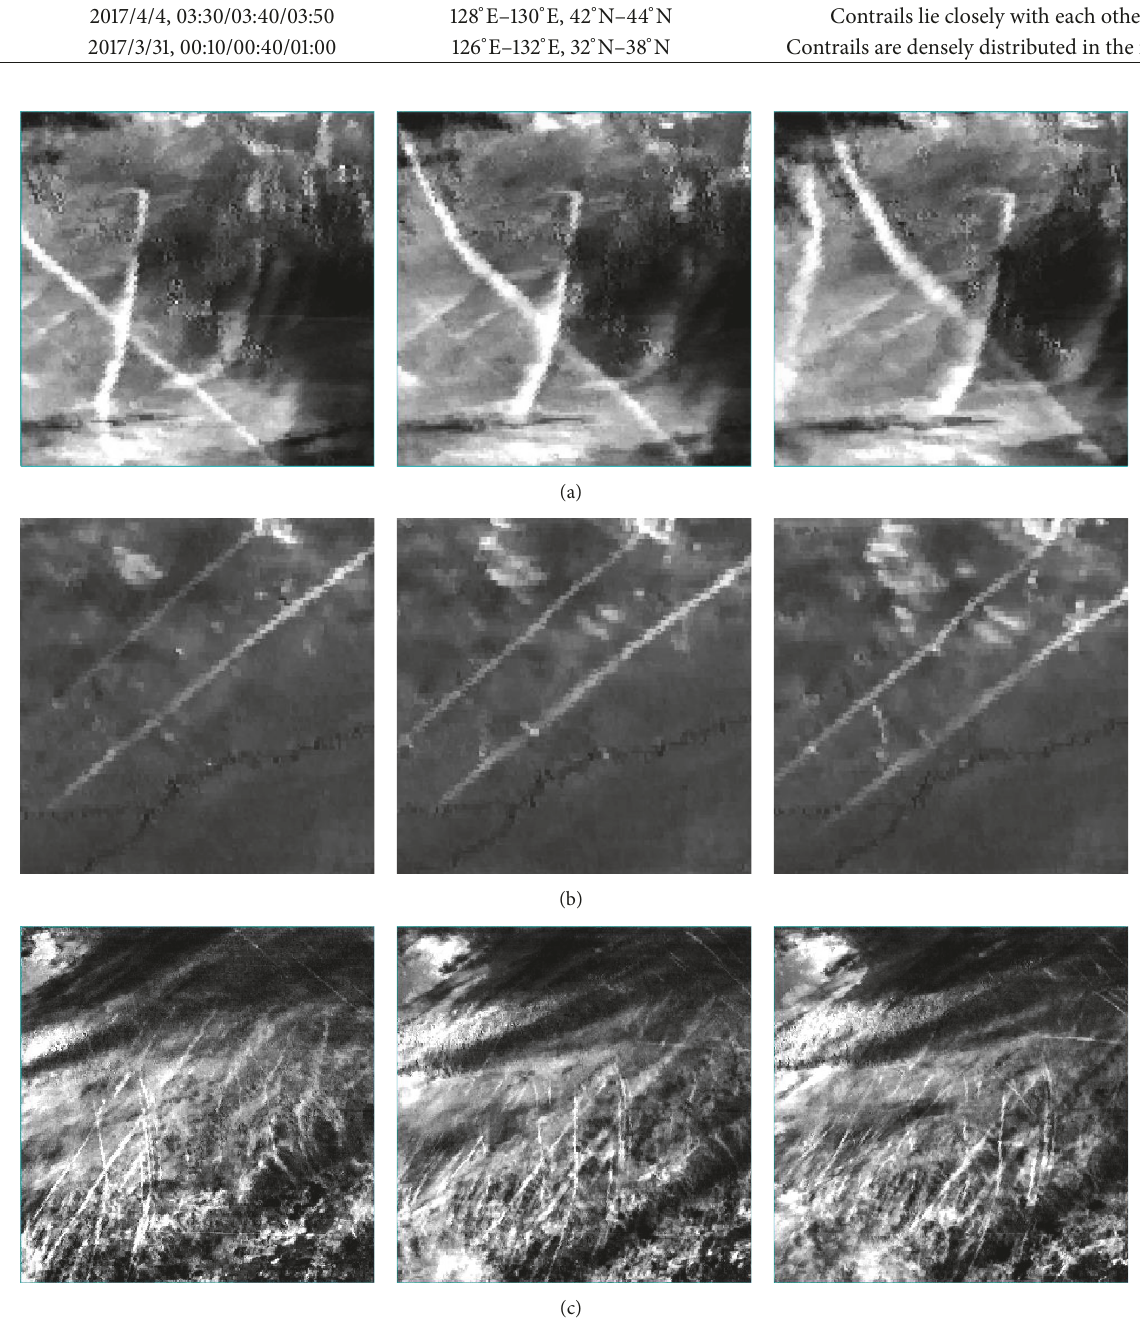
Figure 3: Different scenarios (a), (b), and (c) of contrails distribution according to Table